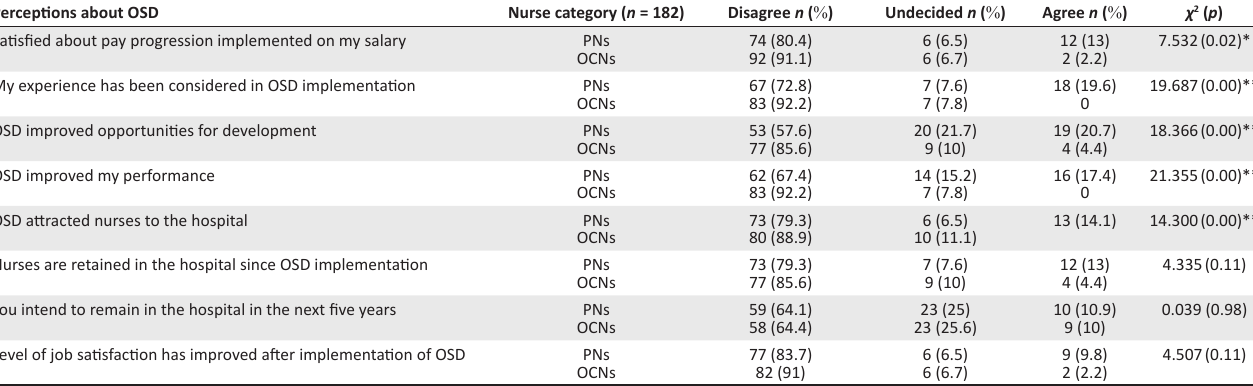
TABLE 5: Perceptions of PNs and OCNs about OSD using the chi-square test ( n = 182). Perceptions about